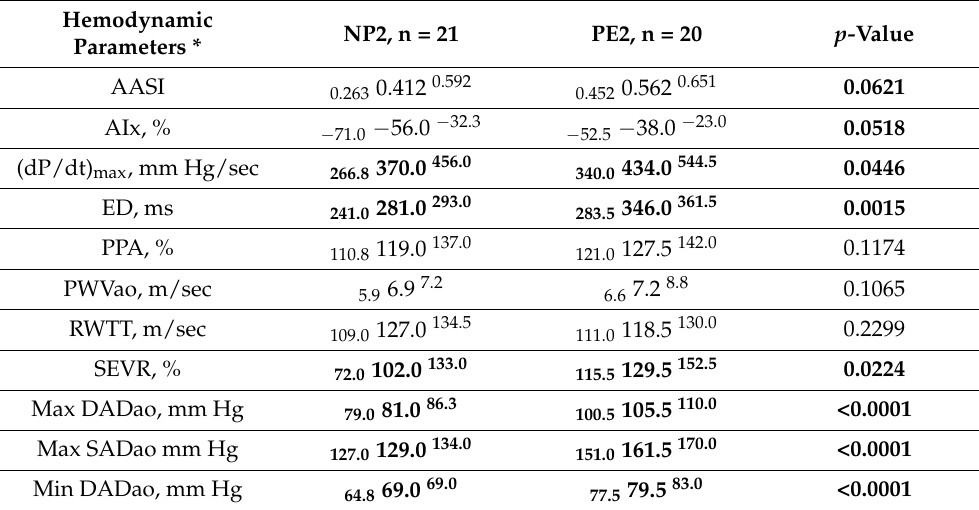
Table 4. Differences in hemodynamic parameters in patients with healthy pregnancy and patients with pregnancy complicated by late-onset